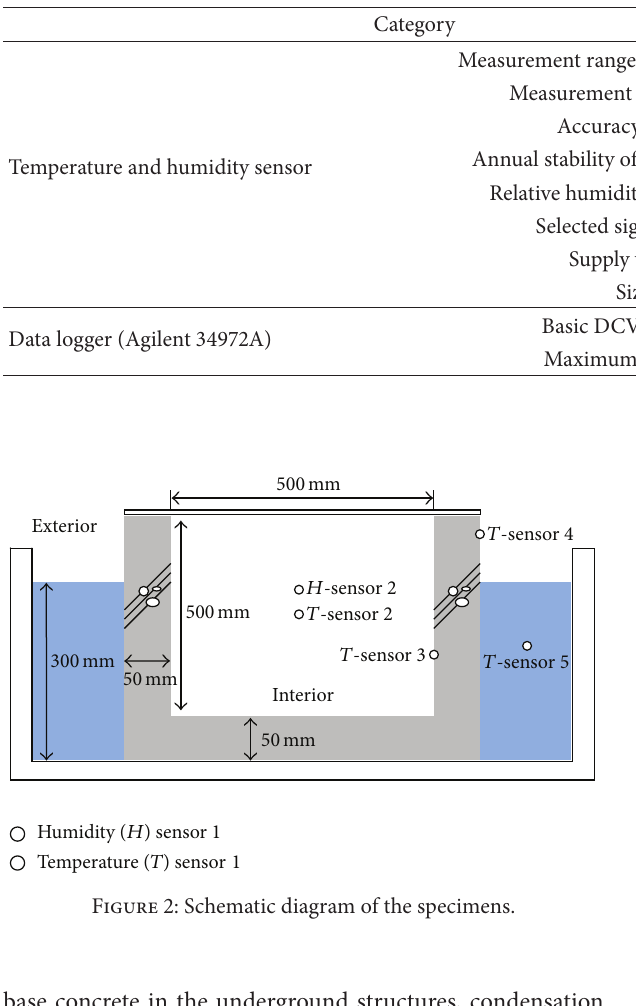
Table 1: Specifications of the temperature and humidity sensor.